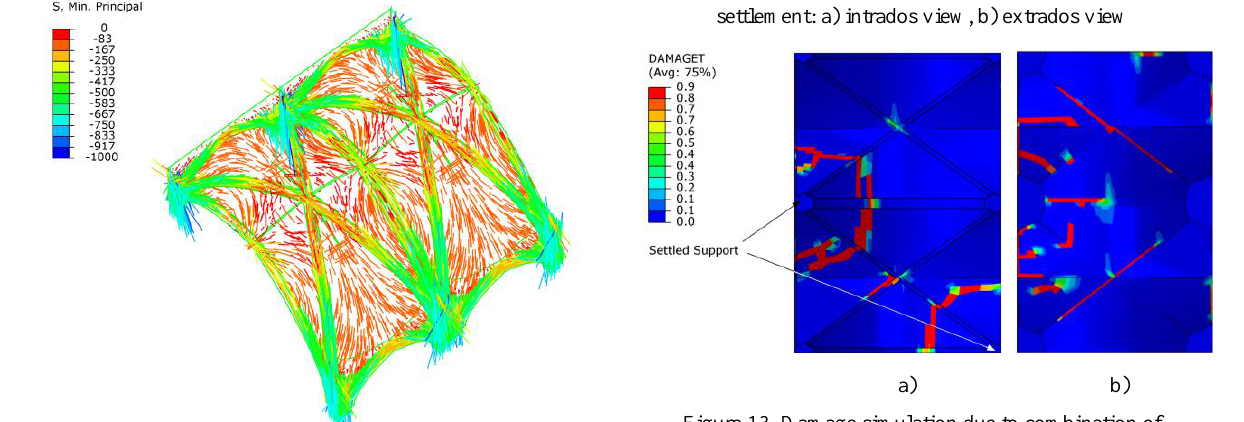
Figure 11. Milan Cathedral: Vector plot of the compressive principal stresses due to self-weight (without settlement)